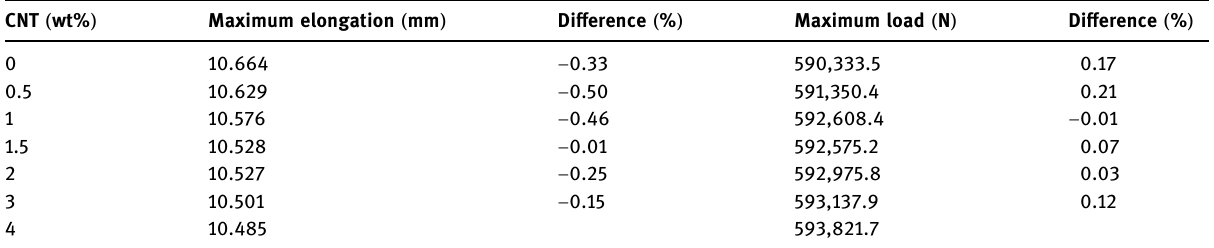
Table 11: Results of the tensile test of rebars